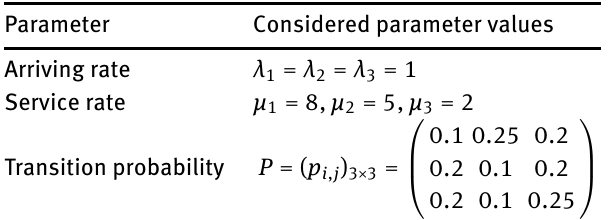
Table 1: Parameter values in 3-queue polling network.